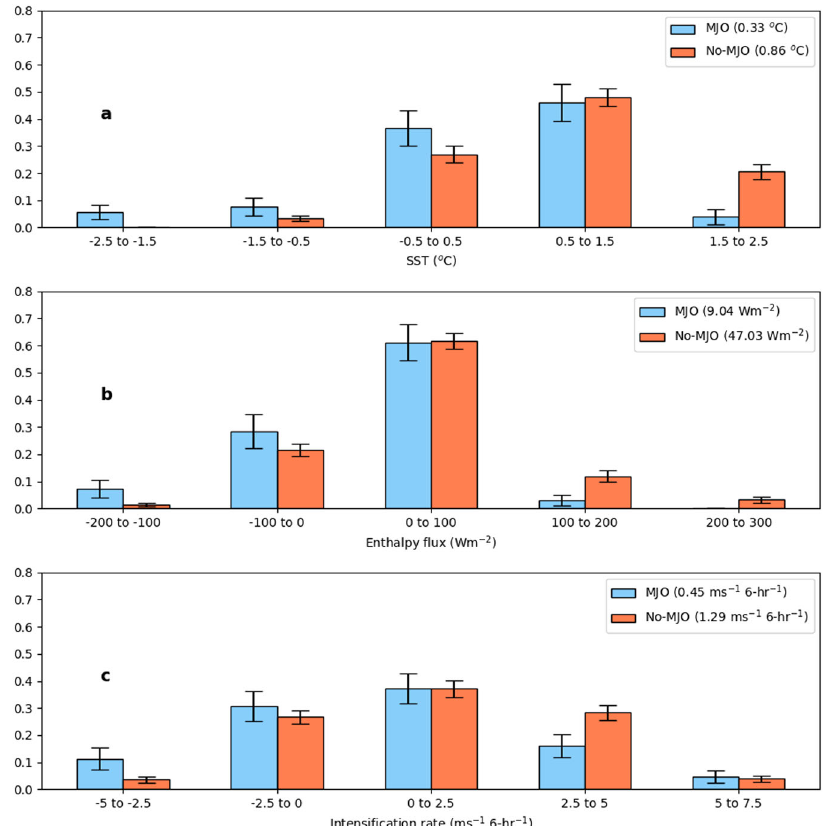
Fig. 2 Observed impact of MJO on TCs. a Probability distribution functions (PDFs) of pre-storm SSTs (°C). b Enthalpy fl uxes under TCs at the air – sea interface (W m − 2 ). c TC intensi fi cation rates (m s − 1 6-hr − 1 . The PDFs in blue (denoted as “ MJO ” ) correspond to those TC track locations that fall within the MJO ’ s Window of Oceanic In fl uence (MWOI), and the PDFs in orange (denoted as “ No-MJO ” ) correspond to those that fall outside the MWOI. In each panel, the mean values are shown in the legend and the error bars representing the standard deviation (s.d.), generated based on the Monte Carlo technique (see “ Methods ” ), are indicated. The difference between mean values are statistically signi fi cant at the 95% level for each parameter. The analysis is based on NOAA OI SST, Woods Hole Oceanographic Institution ’ s Objectively Analyzed air – sea Fluxes for the Global Oceans (WHOI OAFlux), and TC best track